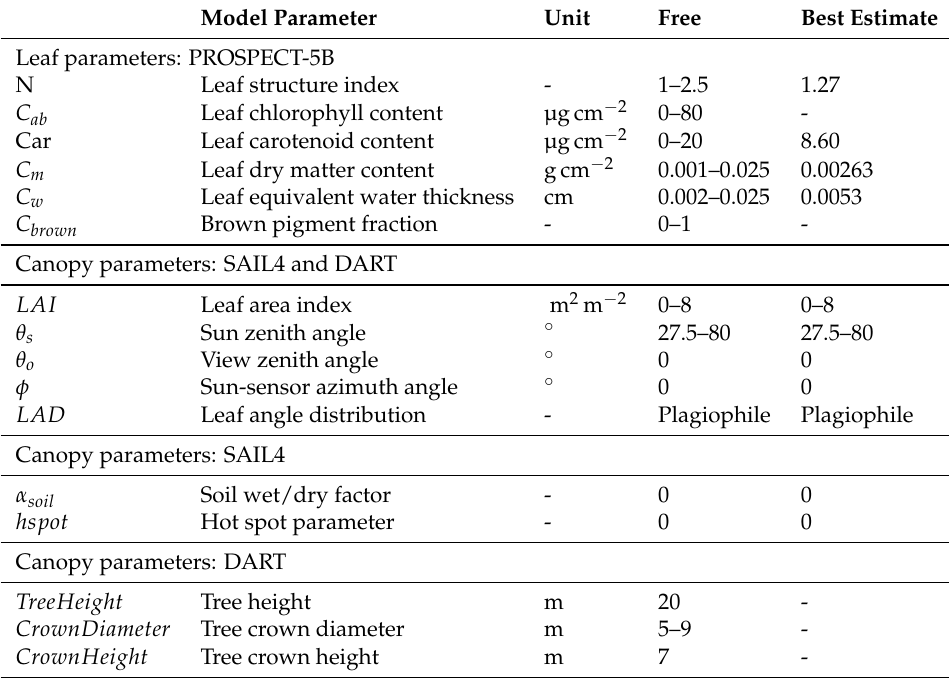
Table 2. RTM parameters with their symbols, units, ranges (in case of free realisations) and best-estimate values (in case of prior knowledge realisations; based on PROSPECT inversion of sampled leaf spectra, Section 3.1). The best-estimate values were used for the prior knowledge